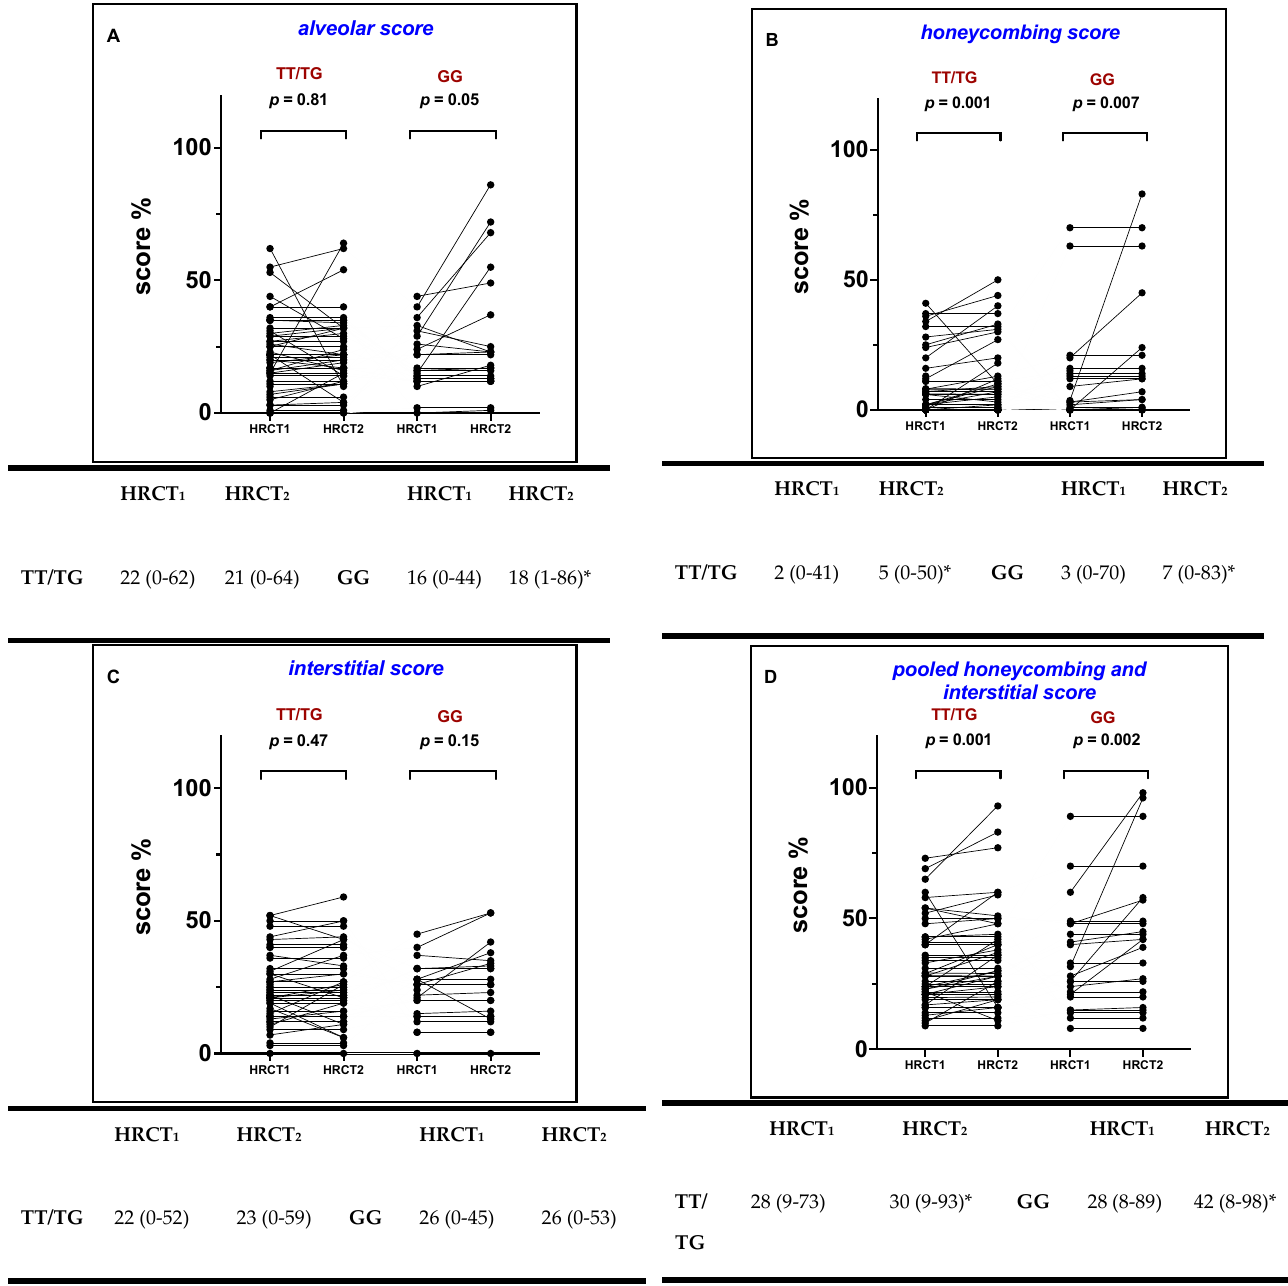
Figure 2. Change in alveolar score (Panel A ), honeycombing (Panel B ), interstitial score (Panel C ) and pooled interstitial score and honeycombing (Panel D ) at treatment initiation (HRCT1) and after one year of treatment (HRCT2) in TT/TG and GG genotype patients. The p values and * refer to comparisons between HRCT1 and HRCT2 and Wilcoxon signed rank test for paired non parametric data was used.